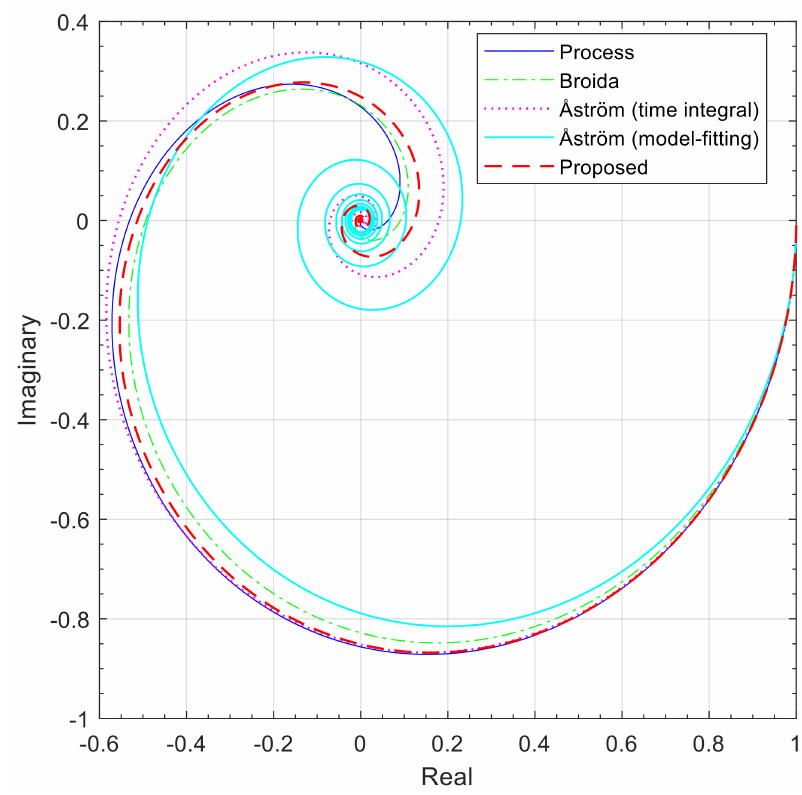
Figure 11. The Nyquist plots for process G P2